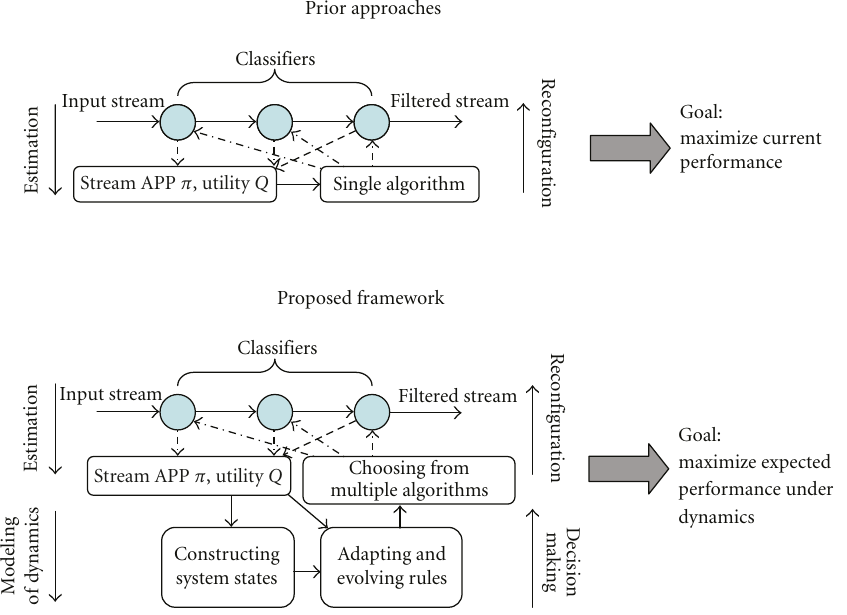
Figure 1: Comparison of prior approaches and the proposed rules-based